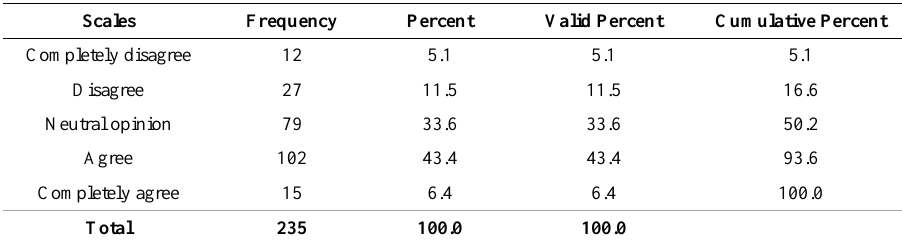
Table 2. Enterprises enhancing the material capacity and 4.0 technology